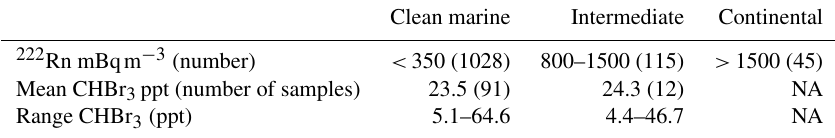
Table 2. Comparison of bromoform mixing ratios from different air mass sources, sorted by radon